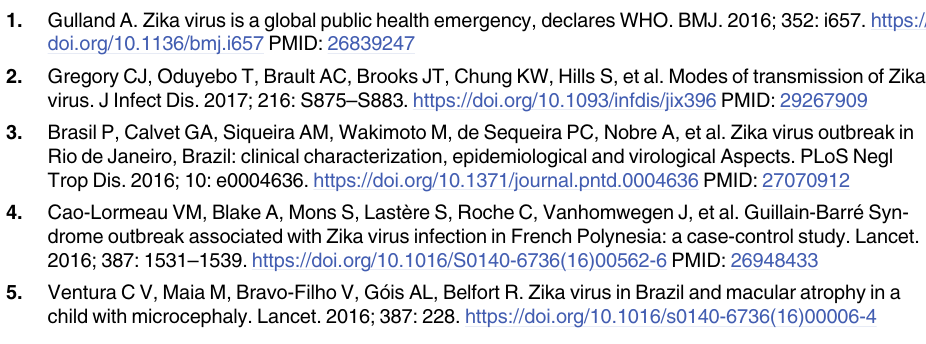
S29 Fig. Immune response summary quantities by inoculum dose for the viral interference model (Eq 3, Table 1). Top: the area under the curve (AUC) of the immune-response- restricted viral production rate ( ^ p ð t Þ ) normalized by the estimated viral production rate in the absence of immune response ( p ) for each animal. Middle: The maximum effect of immune response on viral production rate, with 1 representing complete control of viral production, 0 representing no restriction of viral production. Bottom: the AUC of the total viral production, given by the immune restricted viral production rate ^ p ð t Þ multiplied by the productive infected cell concentration I (t). In each panel, the p-value shown is from a linear regression and where 2 this is statistically significant (p < 0.05) the linear regression line is shown. S30 Fig. The mean predicted viral load (left axis, black) and mean predicted target cell con- centration normalized by T (0) (purple, right axis) at each dose group, from the innate immune model with restricted viral production and viral interference (Eq 3, Table 1). S31 Fig. Viral load (VL) characteristics from 100 simulated viral dynamics profiles with model parameters selected from the fit of the viral interference model (Eq 3, Table 1). Cor- relations between inoculum dose and viral characteristic are assessed via a Pearson correlation, with p -value shown in each panel. Where this relationship is found to be significant at the α = 0.05 level after Bonferroni correction for multiple testing ( m = 6) the linear regression line is shown in the panel. The VL AUC and downslopes are calculated as for the observed viral loads, described in